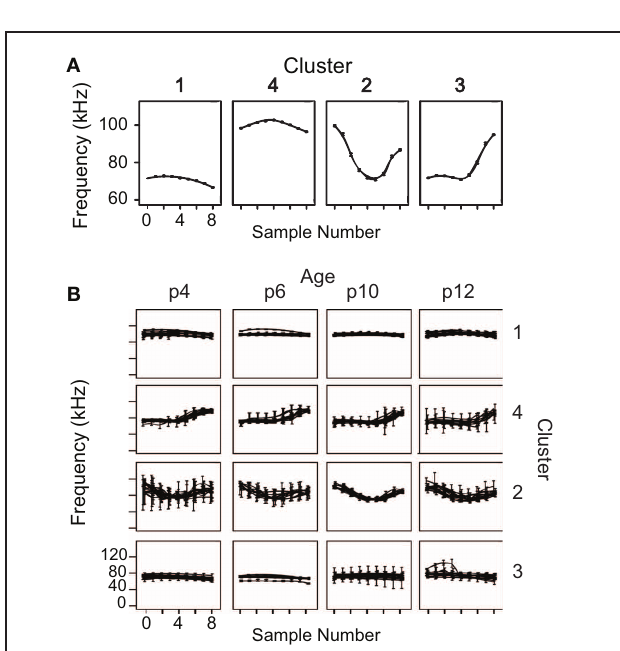
FIGURE 4 | Average frequency contours of the four identified syllable types. (A) Average nine-point frequency contours, with 95% confidence intervals, are shown for the four syllable clusters determined by the two-step clustering algorithm. (B) The average frequency contours for each animal at each age are overlaid, demonstrating a high degree of overlap among animals that is robust across development.